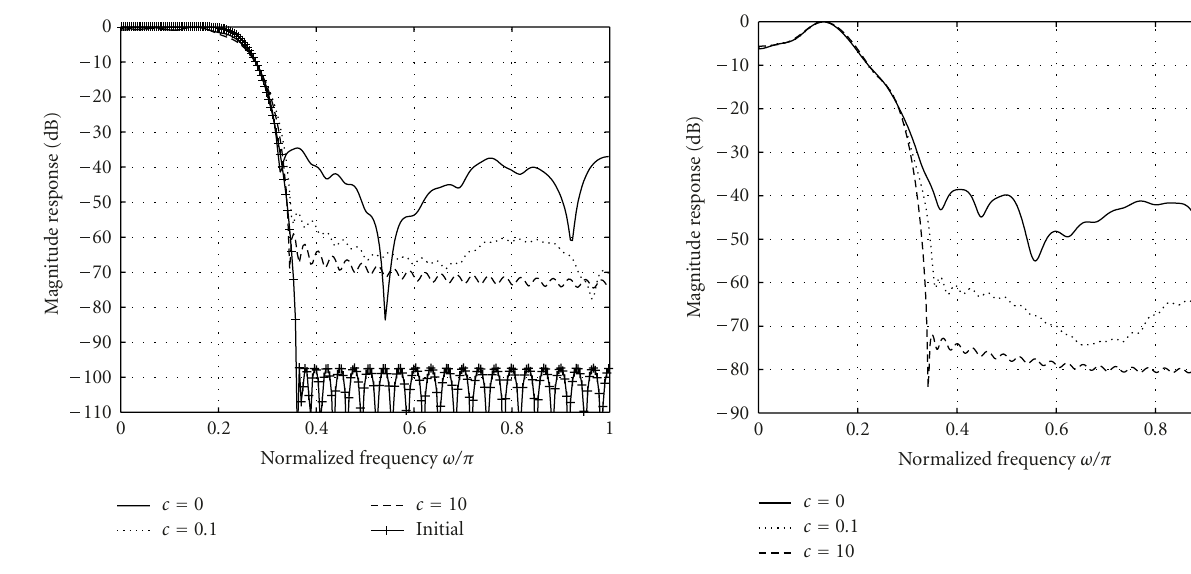
Figure 13: Magnitude response of H 0 ( z